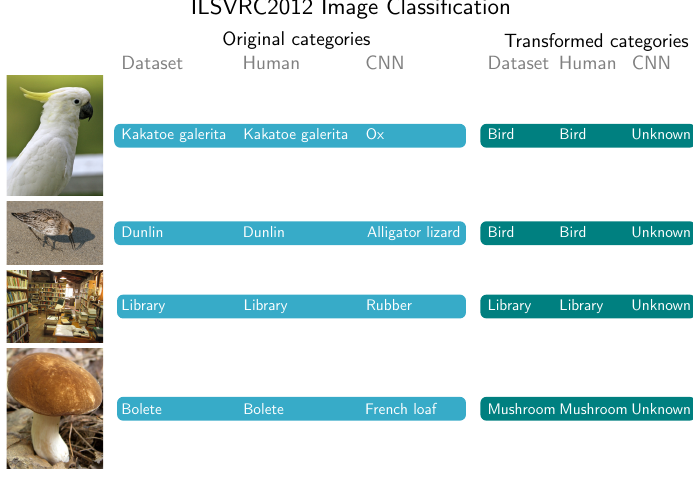
Figure 8. Classification on ILSVRC2012 dataset [19]. When using original categories CNN classifications are absurdly different from true categories. Images are only examples to visually represent a dataset category. They are not part of the dataset. <kakatoe galerita> photo by Lip Kee Yap licensed under CC BY-SA 2.0, <library> photo by Christopher John SSF and <bolete> photo by Jason Hollinger licensed under CC BY